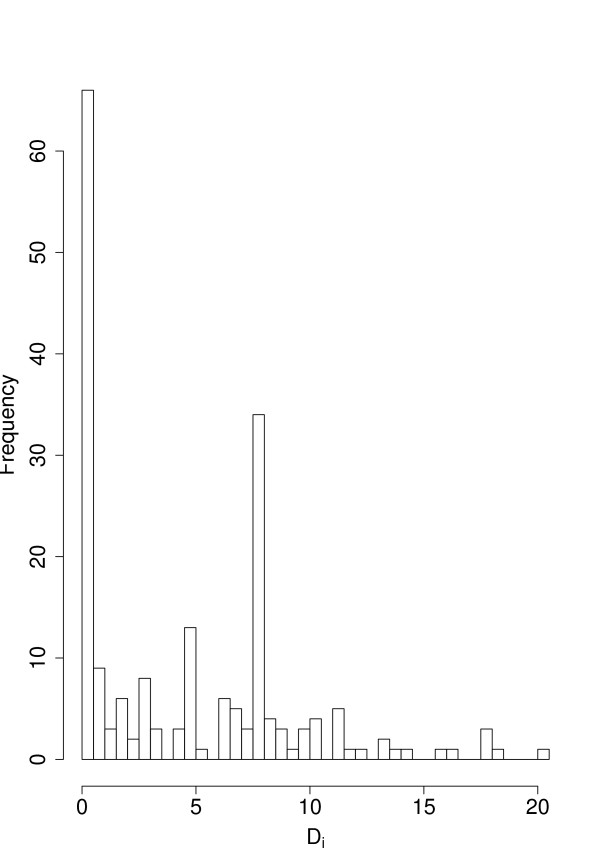
Histogram of Di for all genes with Di > 0.